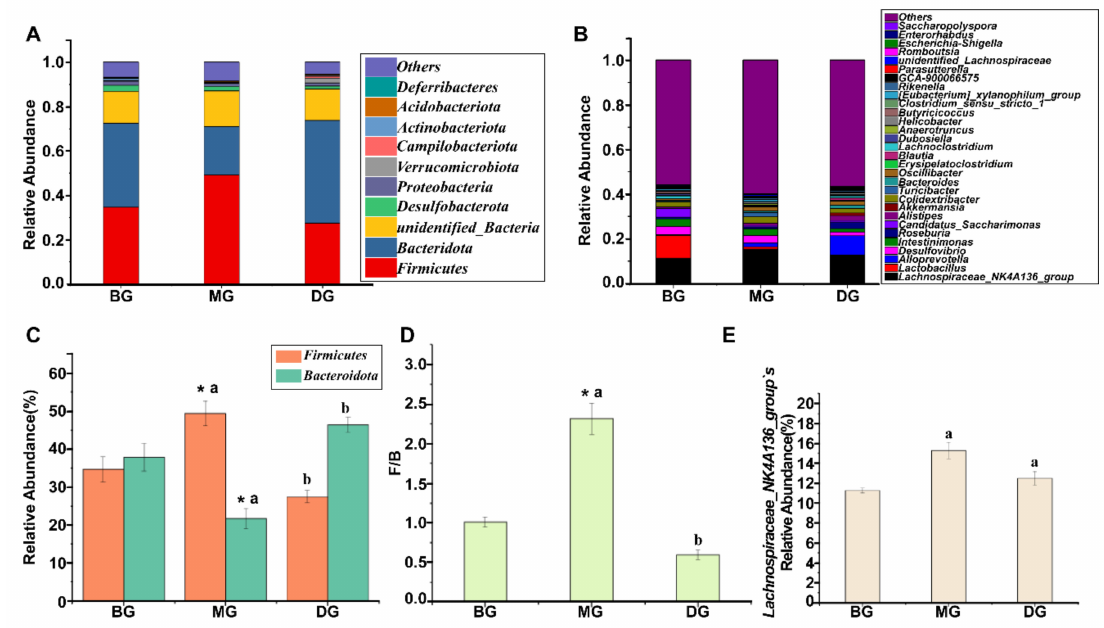
Figure 2. Phylum and genus-level relative abundance. ( A , C , D ) Phylum horizontal relative abun- dance; ( B , E ) Genus horizontal relative abundance. * indicates significant difference between the means of the MG group and the BG group ( p < 0.05), and the different lowercase superscript letters indicate that the means of the MG group and the DG group are statistically significant ( p < 0.05). Data are presented as mean ± standard deviation, calculated from three replicates.